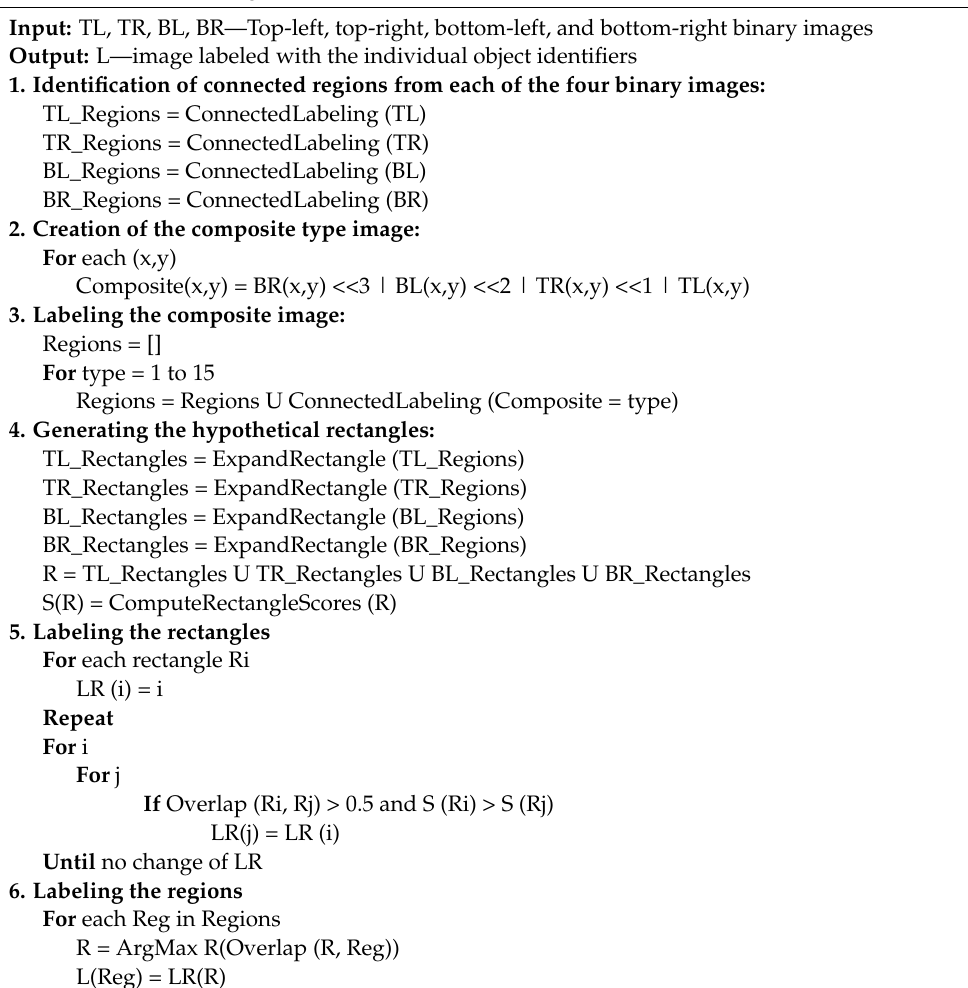
Algorithm 1 Instance segmentation